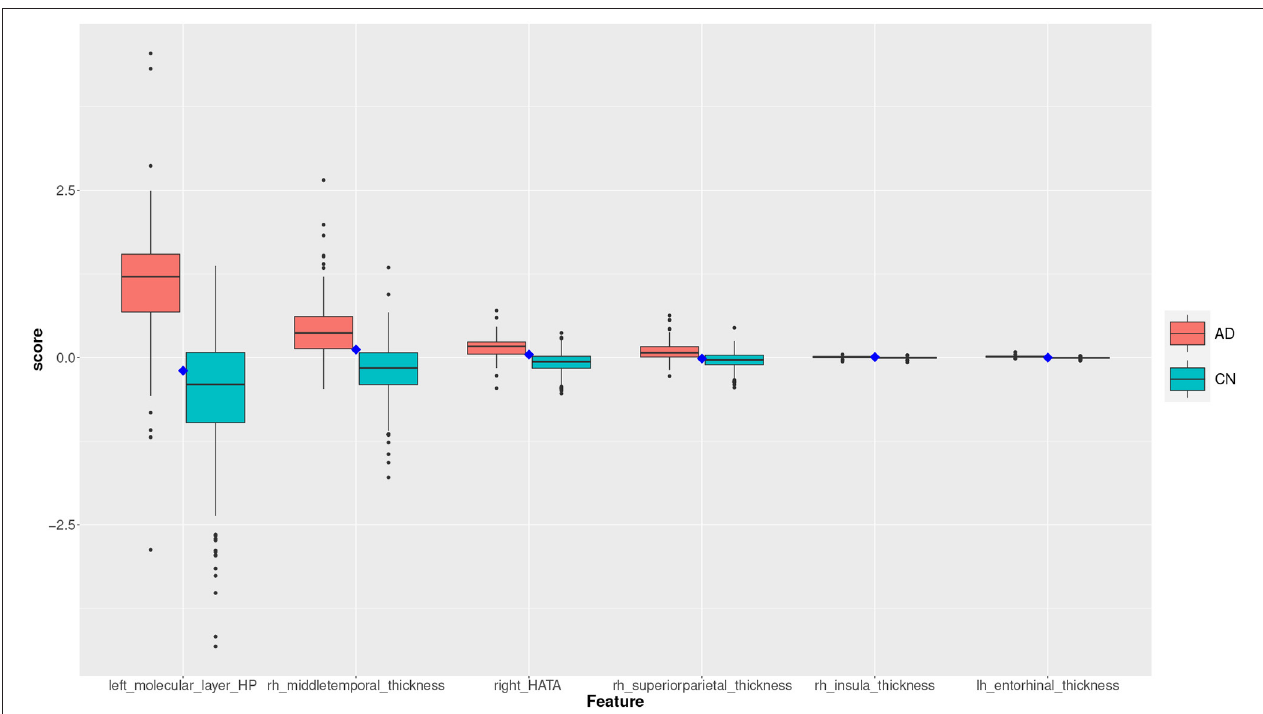
FIGURE 9 | Feature scores of a True Negative (TN) example. The quartiles are generated from the hold-out training data; the example case is selected from the hold-out test data.